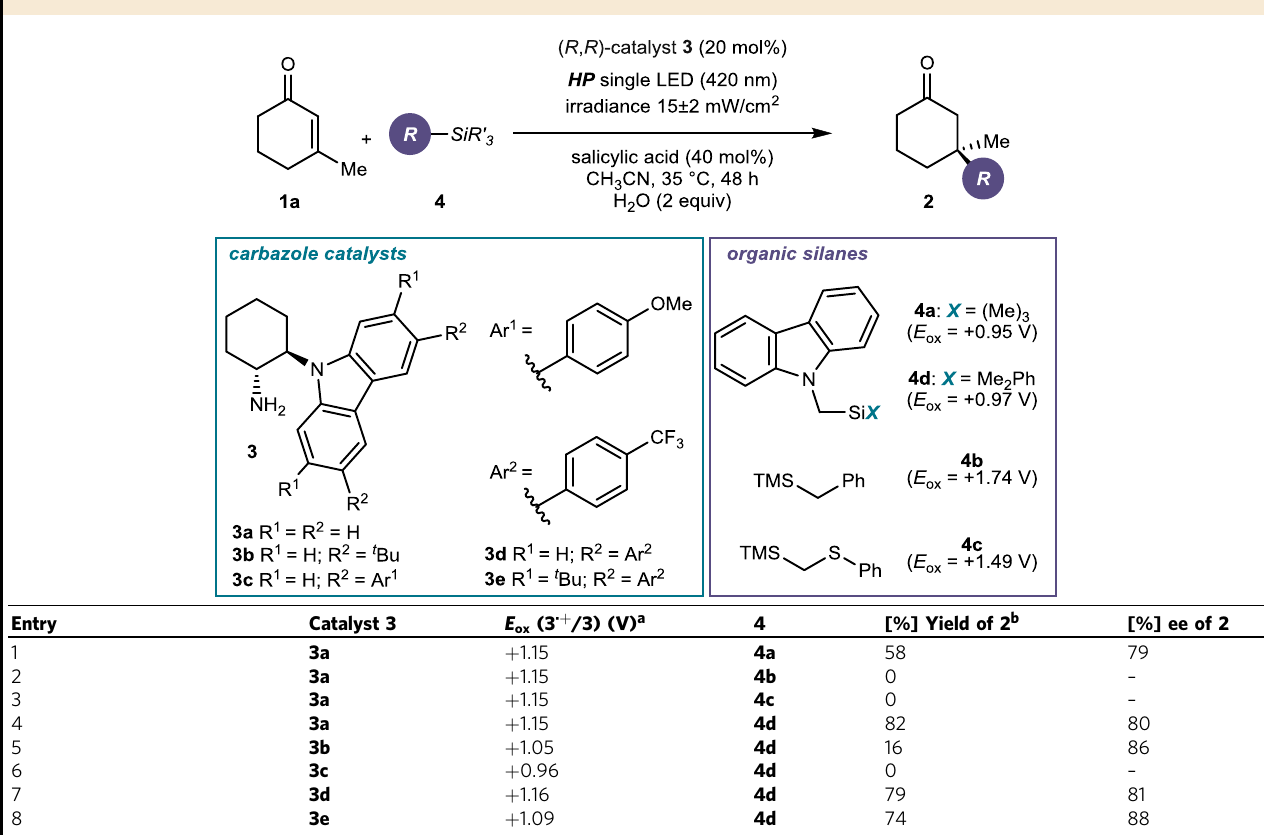
Table 1 Optimization studies